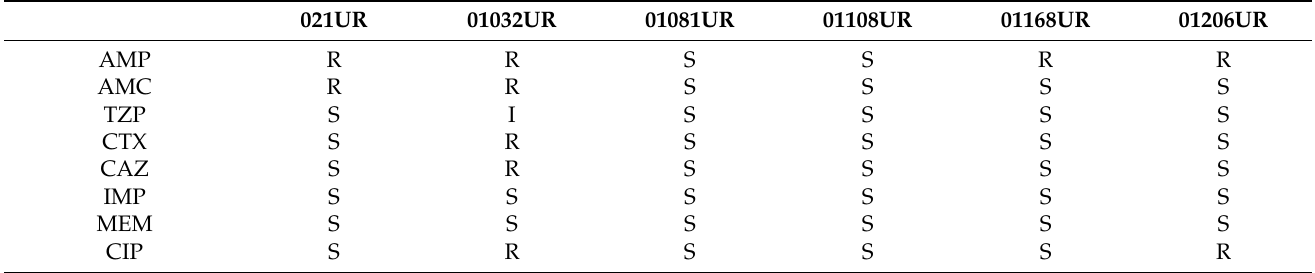
Figure 2. Pyobacteriophag effect before (1 and 1′ ) and after (2 and 2′ ) adaptation to strain 01206UR. Table 2. Results of antimicrobial and phage-susceptibility testing and ability of biofilm formation.